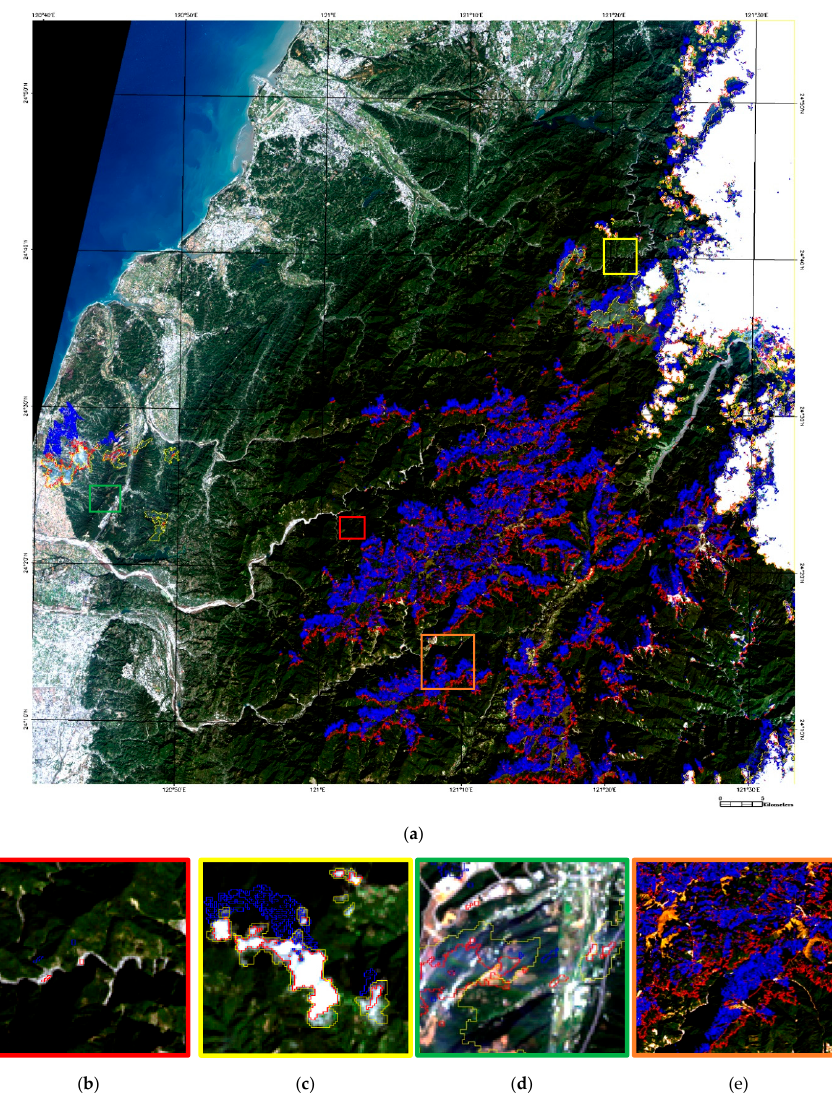
Figure 1. Example of the problems of standard Landsat-8 Level-1 data products in cloud classification. ( a ) Scene P177R043 taken on 24 November 2018, overlaid by corresponding masks of cloud (red line) and shadow (blue line). The regions of red, yellow, green, and orange boxes are enlarged to illustrate ( b ) the case of misclassified clouds over bright targets; ( c ) the case of misclassified thin clouds; ( d ) the case of misclassified haze; and ( e ) the case of misclassified vegetation. The manual (visual) cloud masks are annotated as yellow